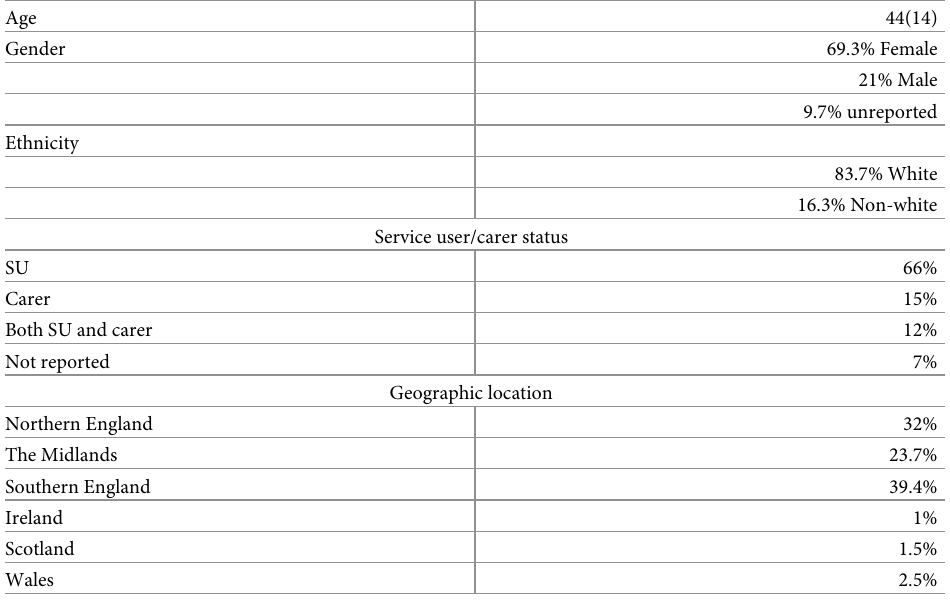
Table 1. Demographic information for 267 participants recruited into the